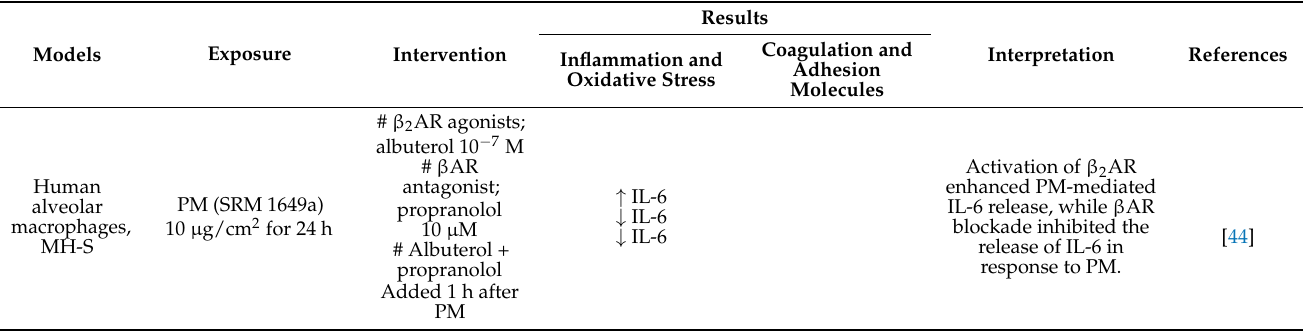
Table 5. The effects of pharmacological interventions on inflammation, oxidative stress, and hemo- static changes following exposure to particulate matter: Evidence from in vitro